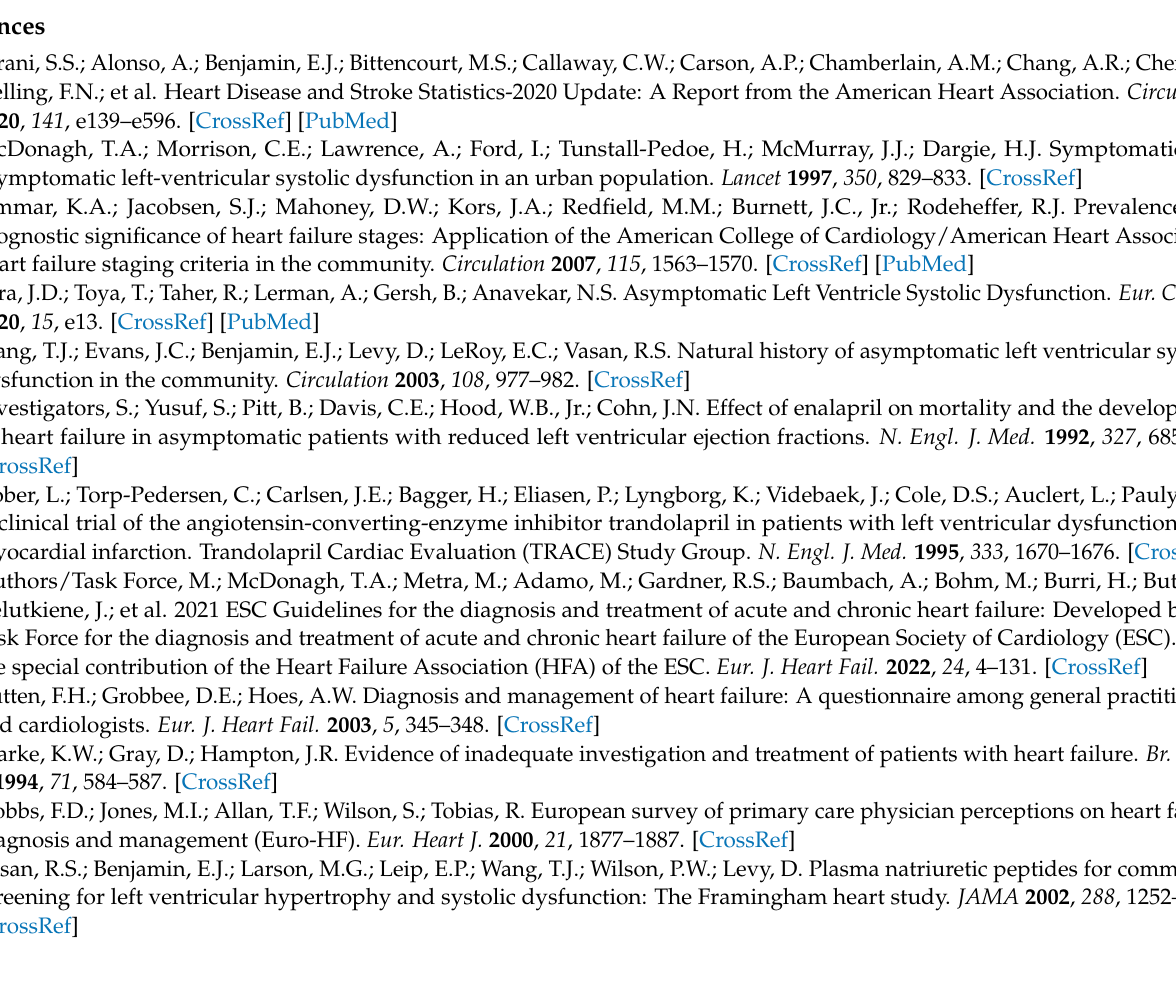
Table S1: Baseline characteristics of patients with ejection fraction EF ≤ 35% and those with EF >